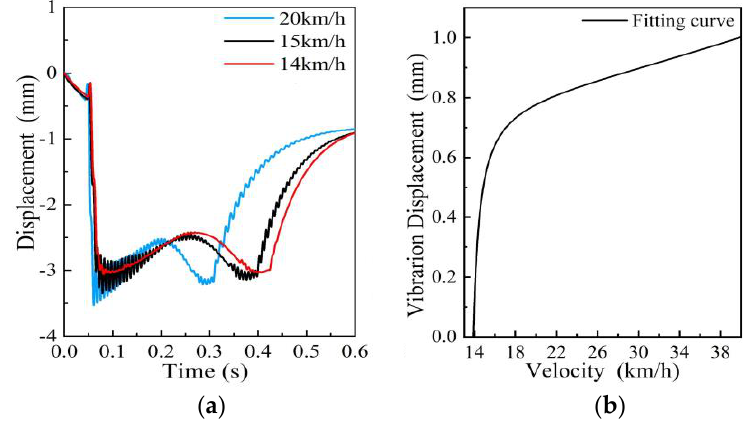
Figure 6. The influence of velocity on the motion process of the measuring ruler: ( a ) Motion curve with different speeds; ( b ) Relationship between speeds and maximum vibration displacements.